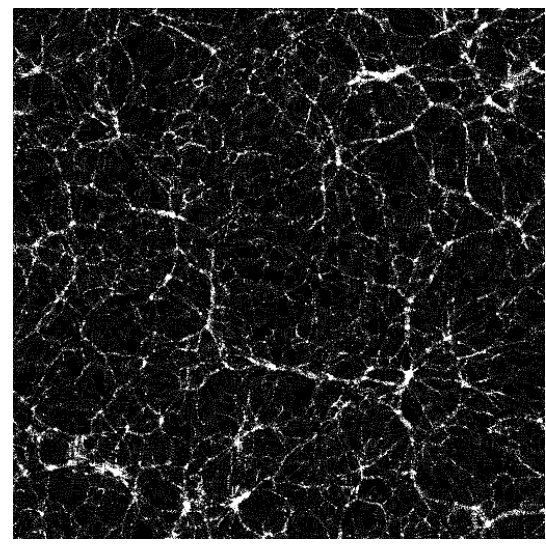
Figure 2. Dark matter slice of Mare Nostrum N -body simulation (cut off at ̺ = 4 ).